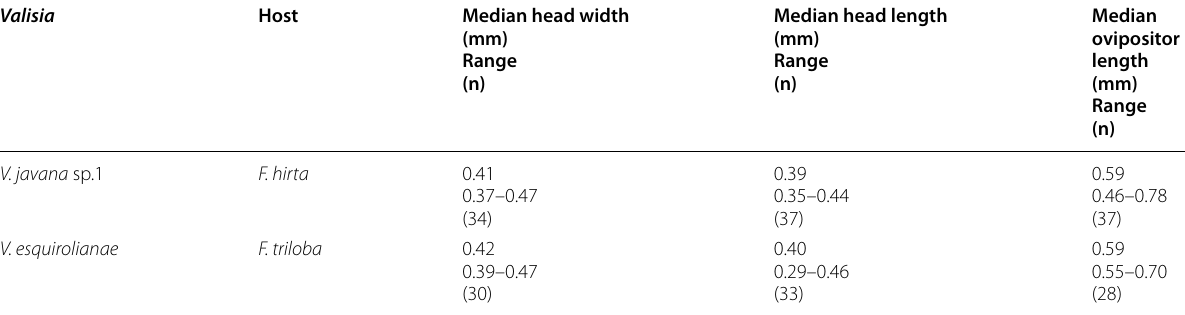
(n) the number of individuals measured. V. esquirolianae had significantly wider heads than V. javana sp. 1 (T = recorded were similar in the two species. There was no significant difference in their head widths (T P P 0.281) = =